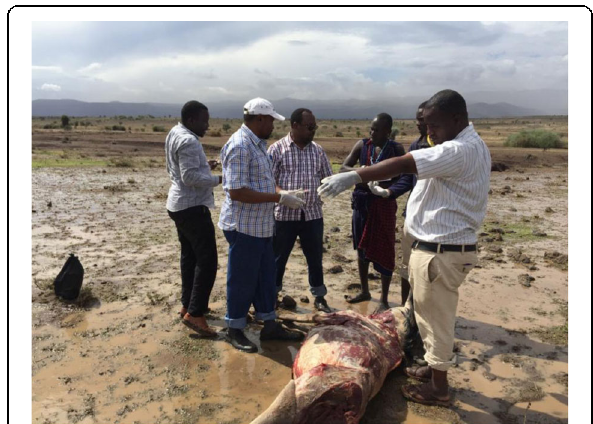
Fig. 4 A carcass of a wildebeest in Monduli district, Arusha region, Tanzania (Courtesy: Elibariki M.